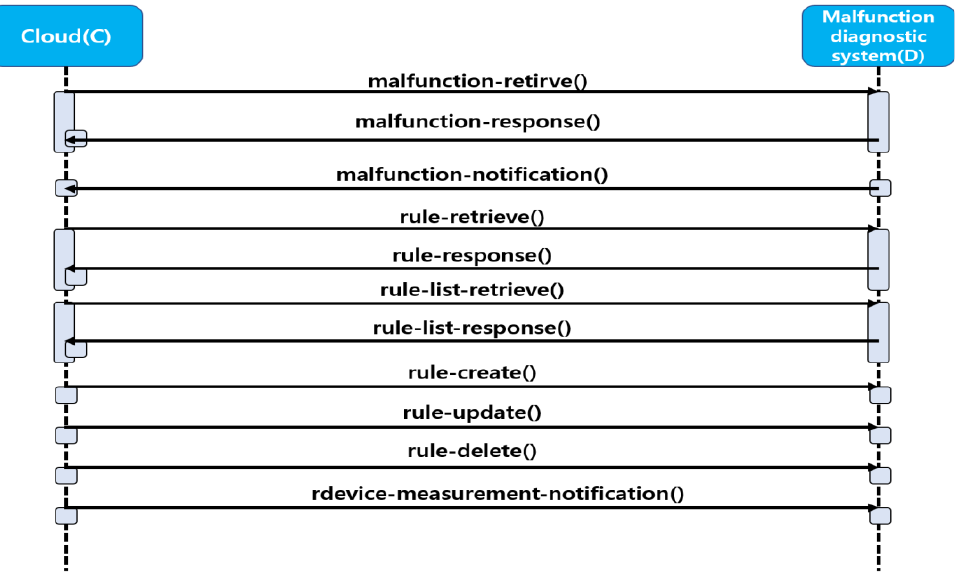
Figure 7. Items of the inspection interface that define the rules for malfunction detection in individ- ual devices. 3.3.2. Ontology Design To detect malfunctions in ventilation devices in a smart barn, the system ontology must be defined to allow the execution of diagnoses founded on a knowledge base. In a barn, key environmental factors are measured by sensors, and the data are compiled through sensor networks. Therefore, we defined the ontology of our system based on the semantic sensor network ontology [30]. The semantic sensor network ontology was designed for versatility in various as- pects, including the detection target, detection method, metadata, batch system with sen- sors, and other attributes. Due to its complexity, the semantic sensor network ontology (in